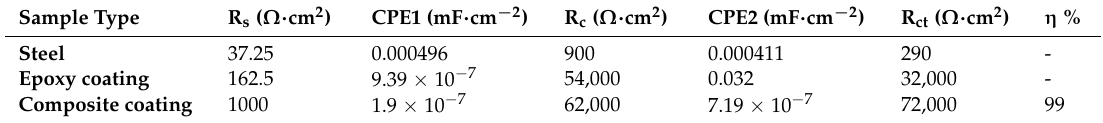
Table 1. Electrochemical parameters derived from the impedance plot.